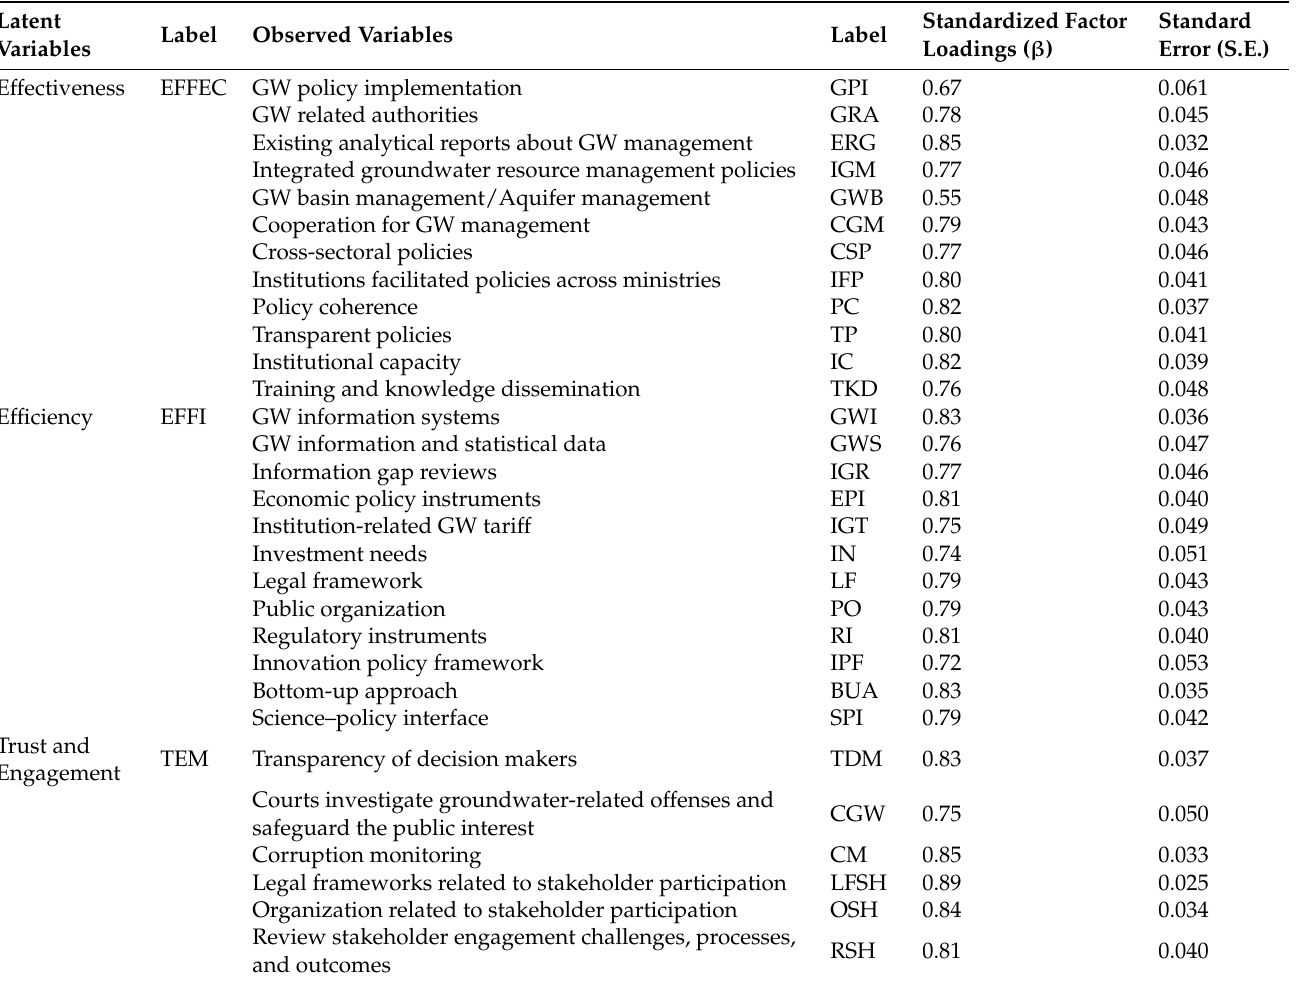
Table A2. Factor loading and standard error of 36 GWG